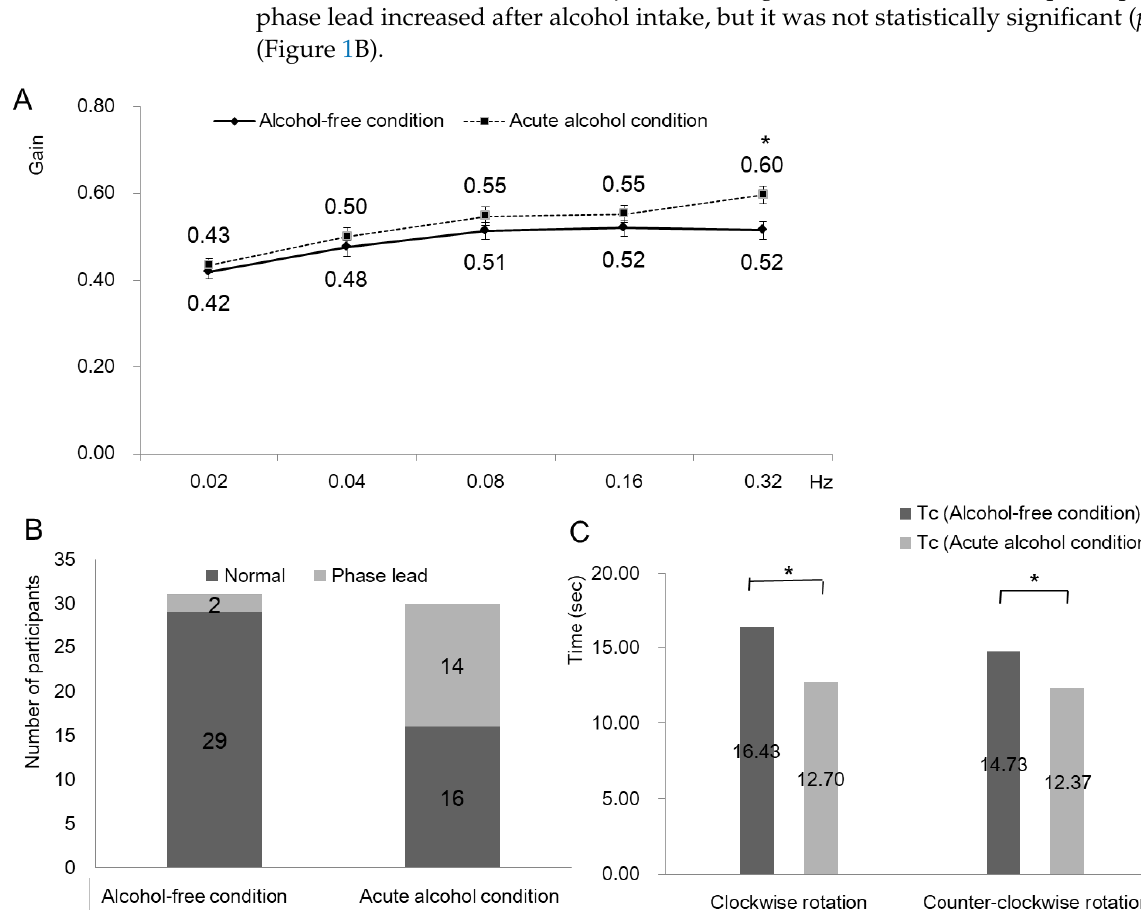
Mean Value Acute Alcohol Condition